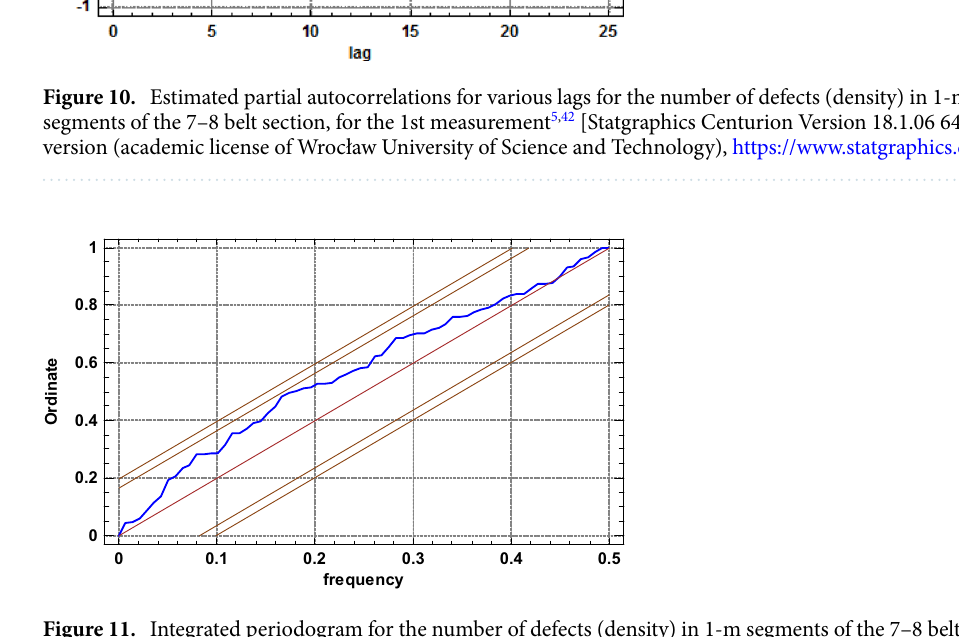
Figure 11. Integrated periodogram for the number of defects (density) in 1-m segments of the 7–8 belt section along its axis for 1st scan 5,42 [Statgraphics Centurion Version 18.1.06 64-bit version (academic license of Wrocław University of Science and Technology), https:// www. statg raphi cs.